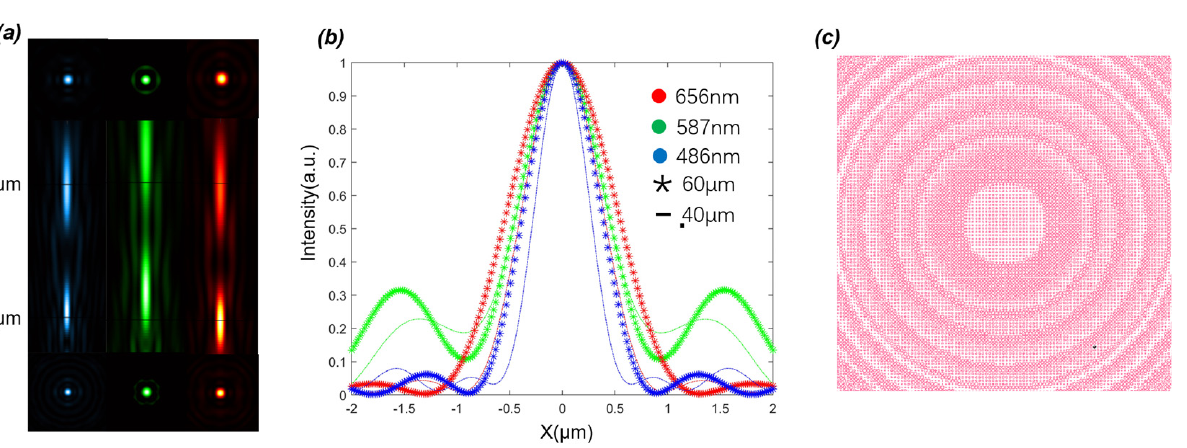
Table 1. Focal position, efficiency, and FWHM of metasurface.